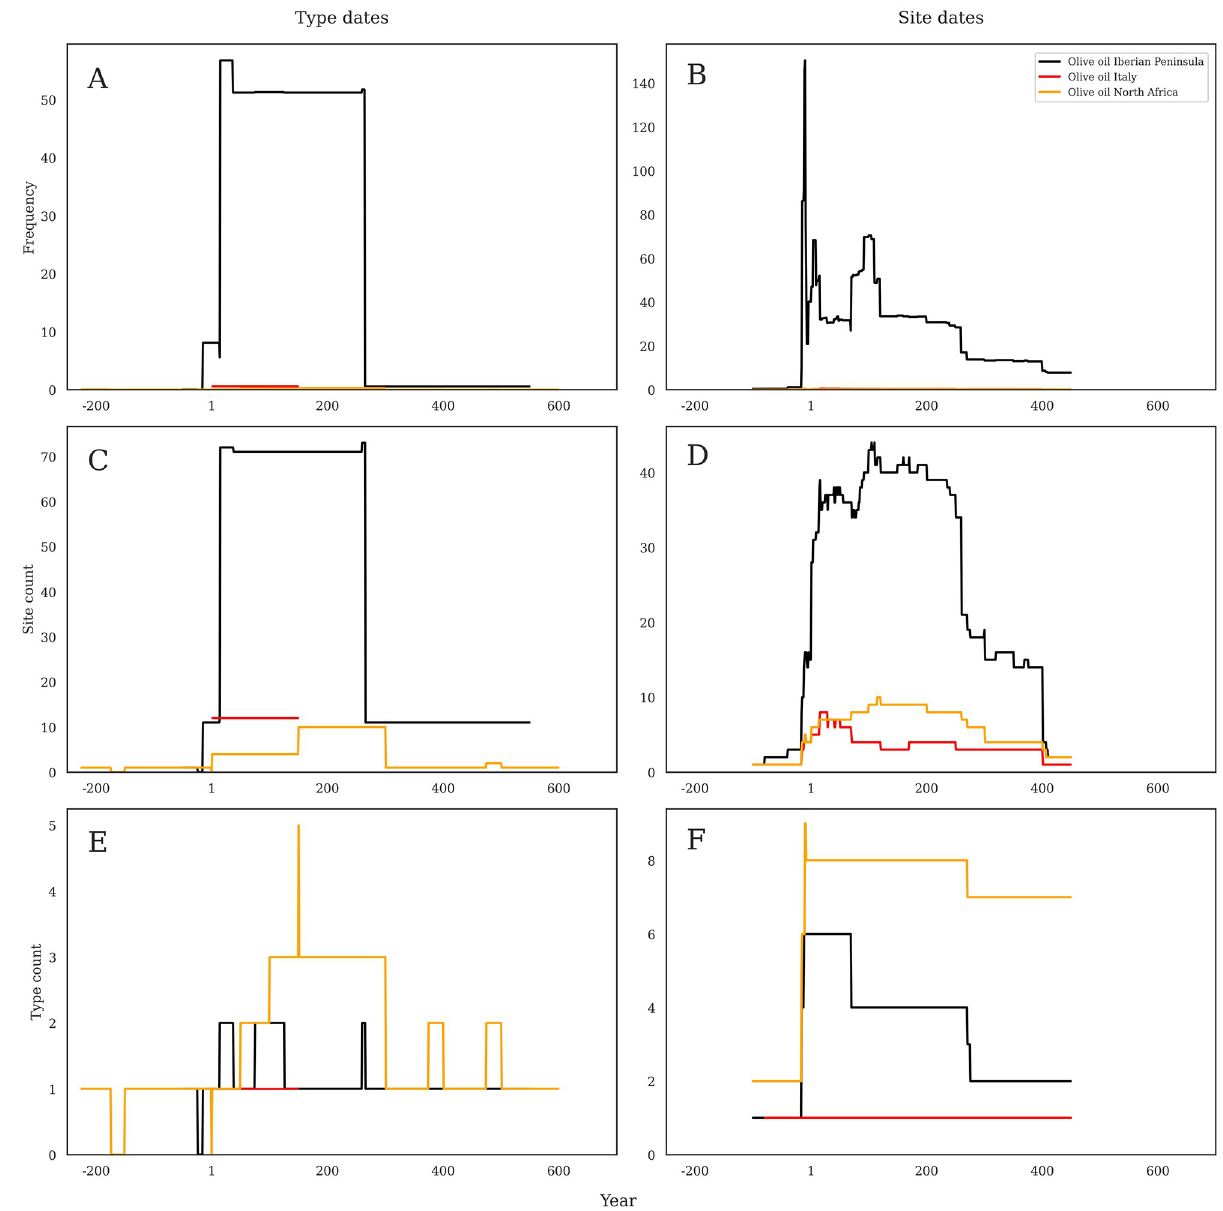
Fig 8. a-f. Olive oil consumption through time. Comparison of three main olive oil-producing regions across the three different methods of analysis according to production dates (left) and consumption dates (right). Note that Y axes are not constant.